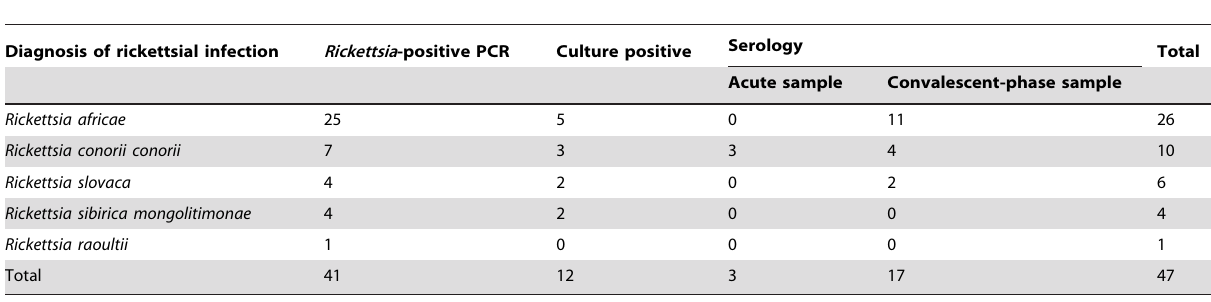
Table 1. Results of PCR assay, culture and serology for the 145 patients tested.